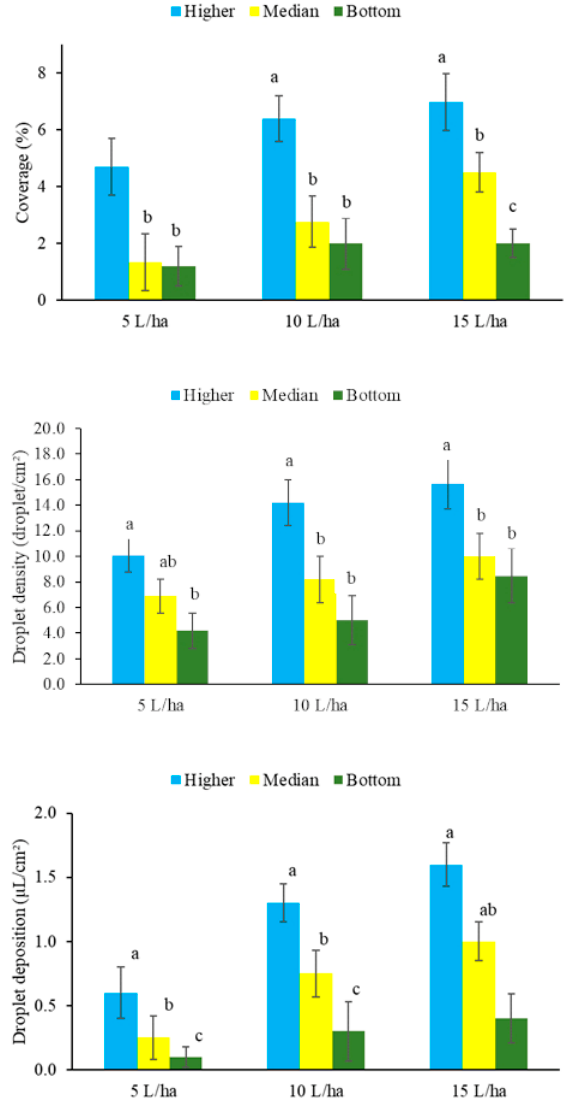
Figure 8. Droplet distribution in coffee plant canopy layers using different application rates. Bars represent the treatments: T1, T2, T3, T4, T5, T6, T7, T8, and T9, from left to right. Means followed by the same lower-case letter between application rates do not differ at 0.05 level of significance by Tukey’s test.